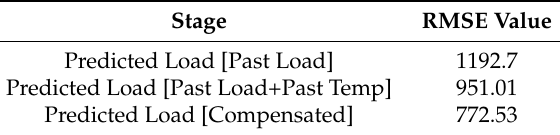
Figure 12. Winter load prediction. Table 9. RMSE value for winter